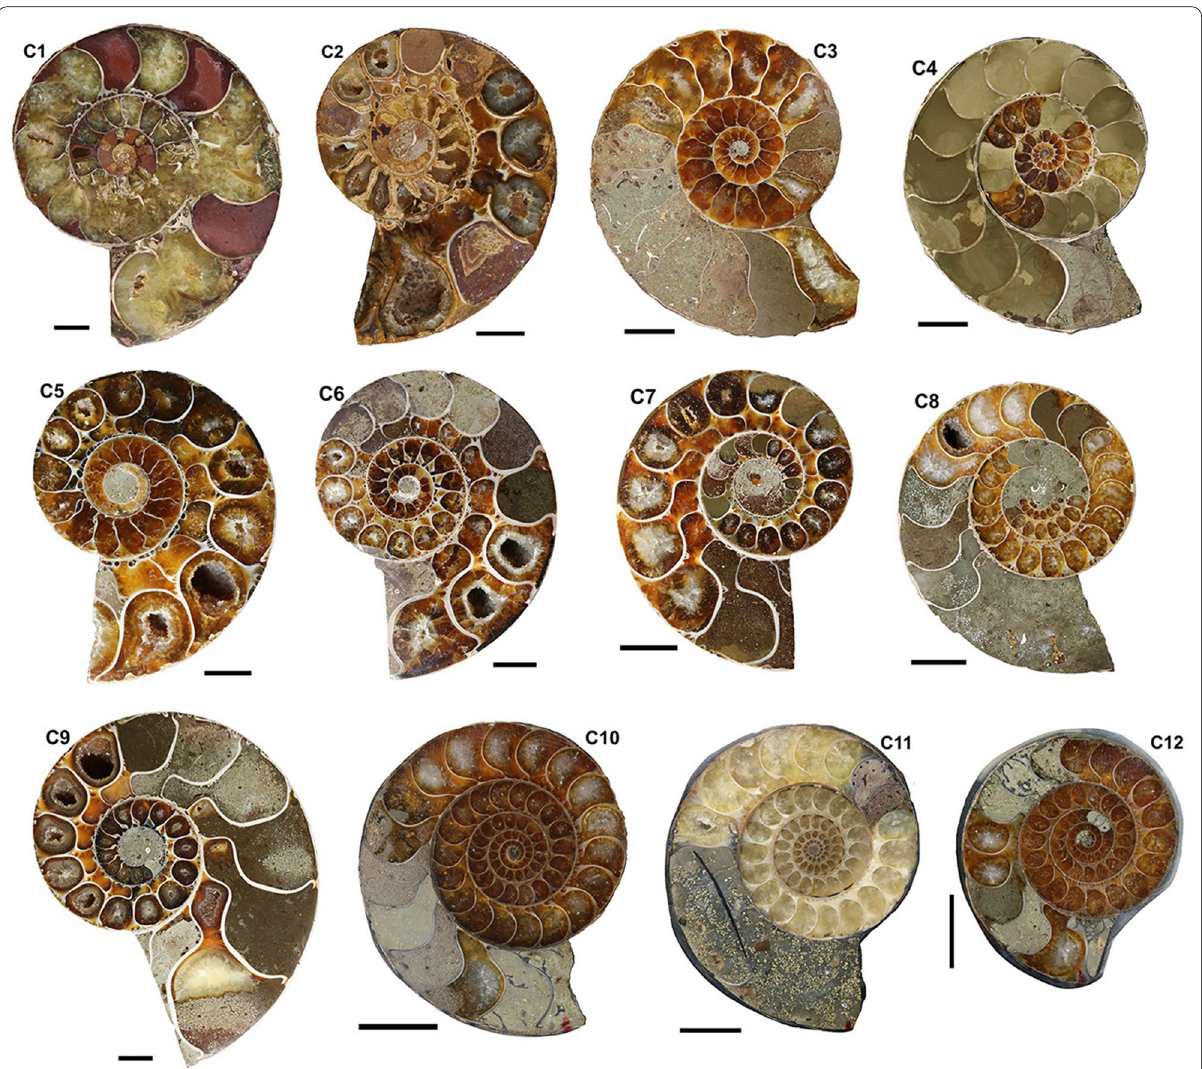
Fig. 4 Cretaceous ammonoids, Albian, Madagascar (for details see Table 1). (C1, C2, C5, C7, C9) Argonauticeras besairei . (C1), PIMUZ 31258, (C2) (PIMUZ 37664), (C3) Cleoniceras sp. RUB-Pal 14106-2G, (C4) Desmoceras sp. (RUB-Pal 14107-2H), (C5) RUB-Pal 14102, (C6) Gaudryceras sp. (RUB-Pal), (C7) RUB-Pal 14103, (C8 to C12) Eogaudryceras umbilicostriatus , (C8) RUB-Pal 14101C, (C9) RUB-Pal 14104–3.11b, (C10) RUB-Pal 14101A, (C11) RUB-Pal 14101B, (C12) RUB-Pal 14101D. Scale bar 1 =